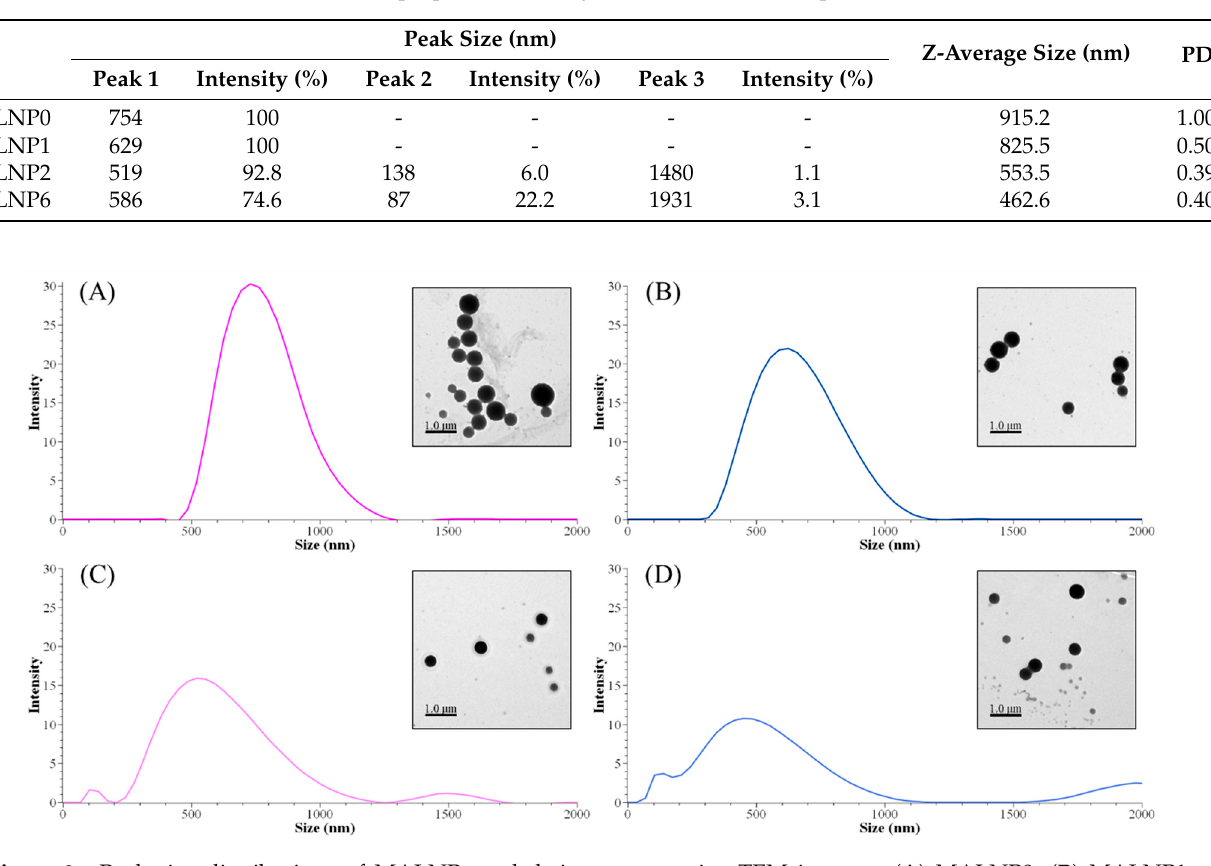
Figure 3. Peak size distributions of MALNPs and their representative TEM images. ( A ) MALNP0, ( B ) MALNP1, ( C ) MALNP2, and ( D ) MALNP6.